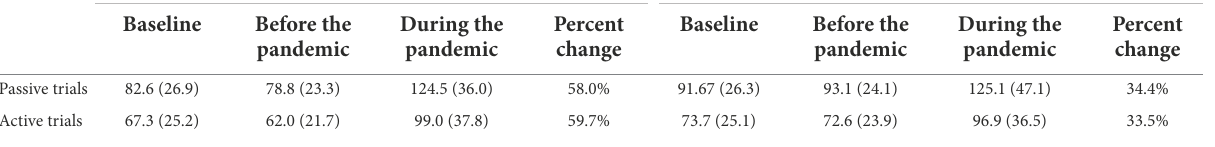
TABLE 1 Personal space size measurements, Cohort